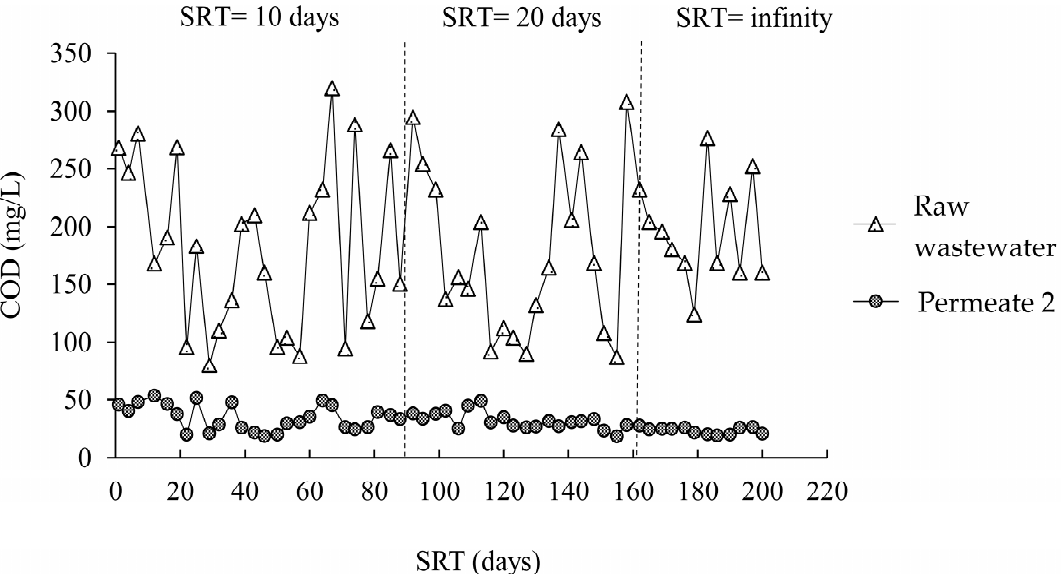
Figure 4. COD concentrations during the experiment at different SRTs in the O-MBR system (System 2). Table 2. Effects of the A/O-MBR and O-MBR systems on COD removal.